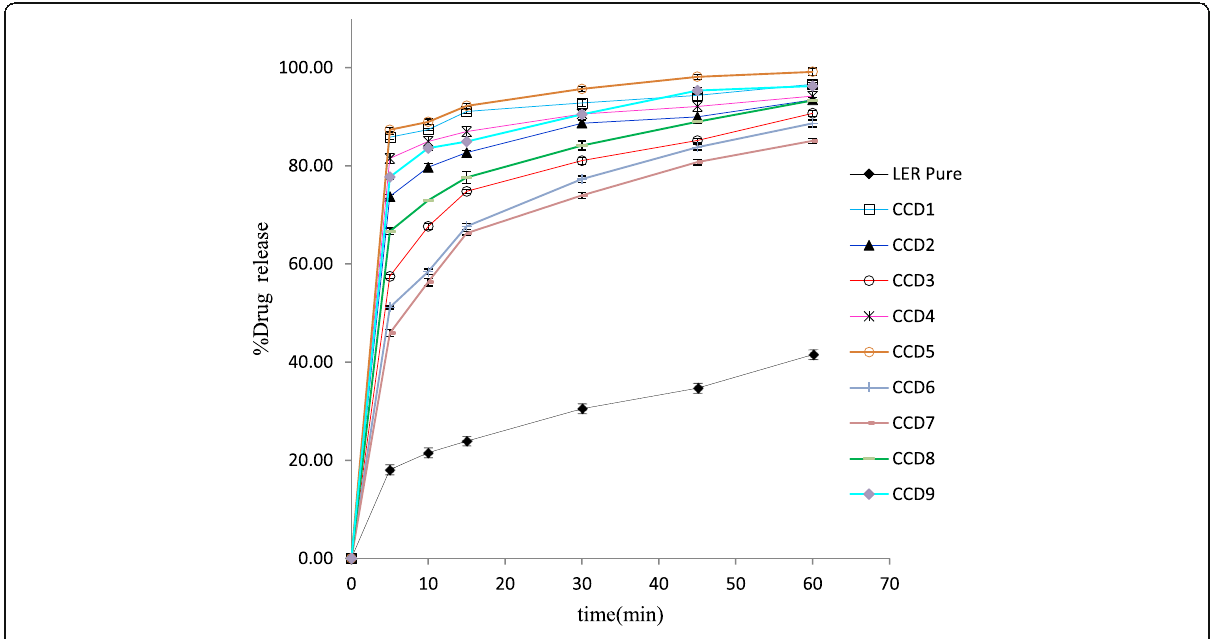
Fig. 6 In vitro dissolution studies of batches CCD1 – CCD9 (average ± SD, n =